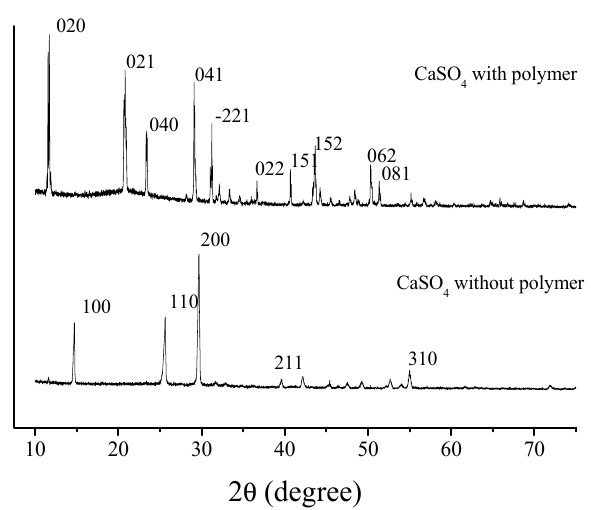
Figure 7. X-ray diffraction pattern of CaSO 4 crystals obtained from blank solution and solutions with 10 mg/L polymer inhibitors.